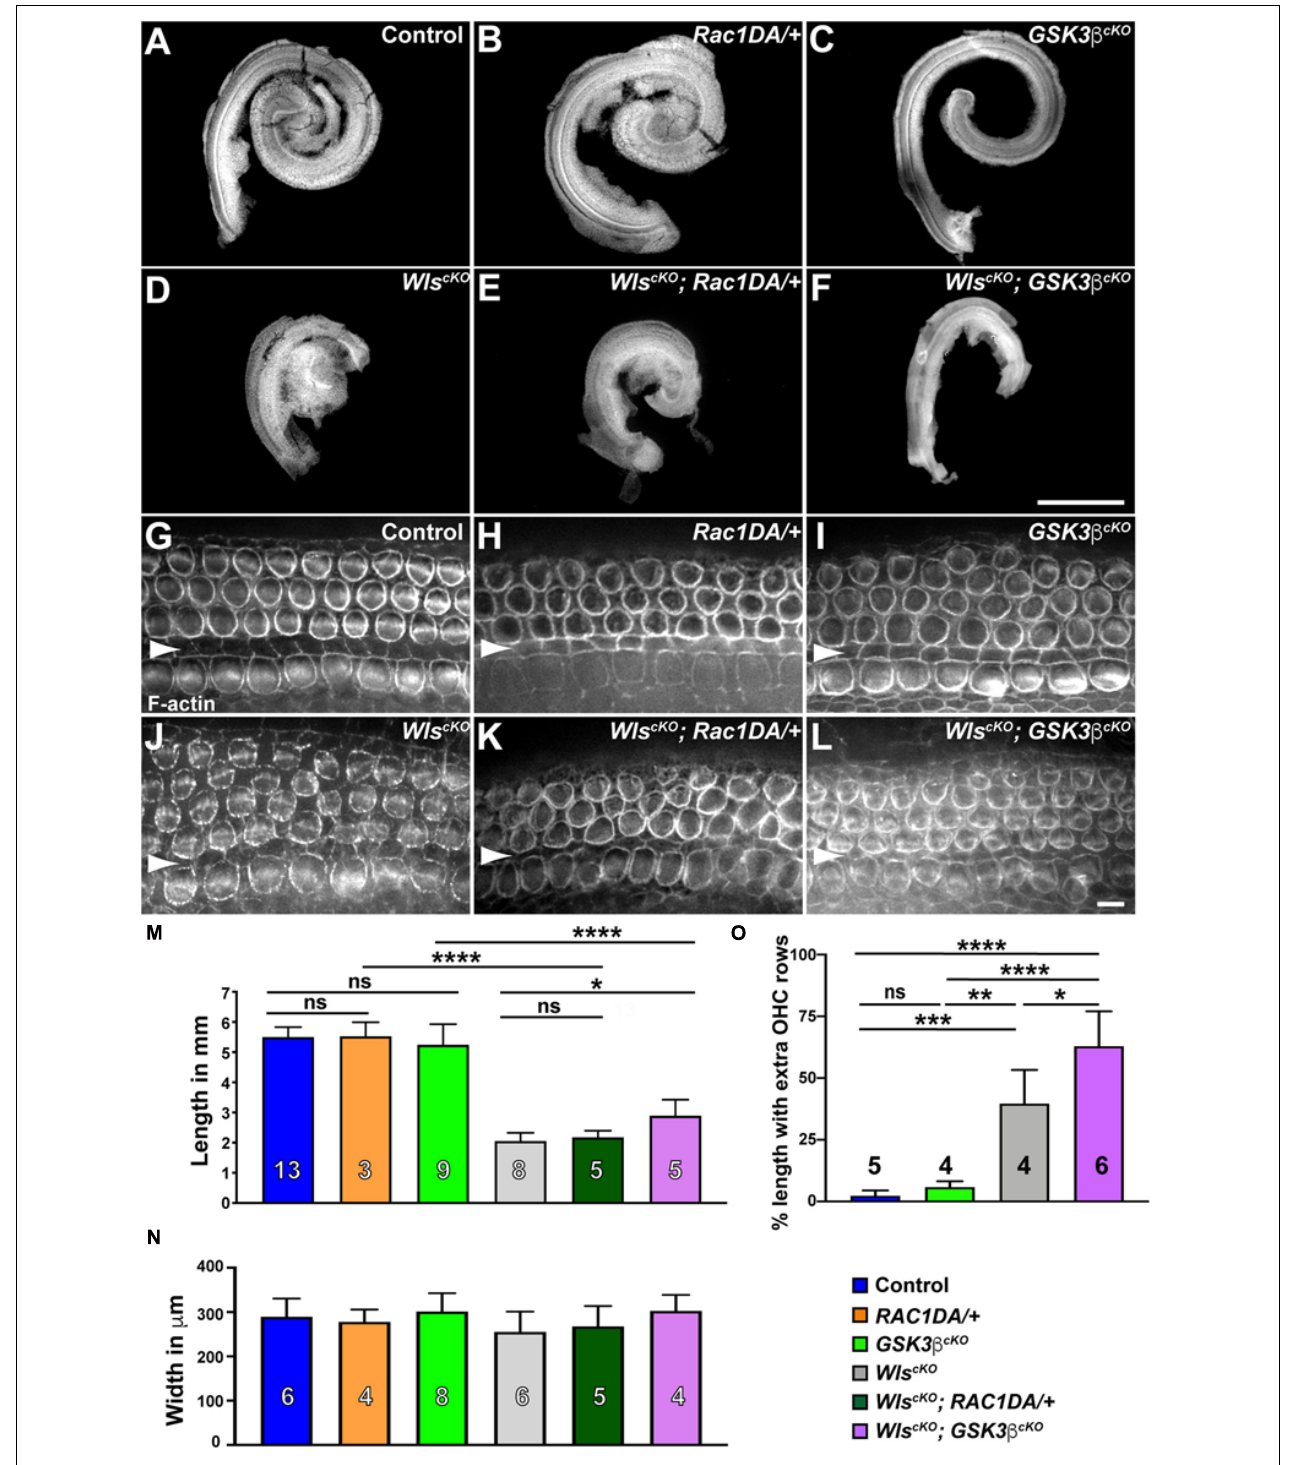
FIGURE 3 | Gsk3 β inactivation but not Rac1 activation partially rescued cochlear outgrowth of Wls cKO mutant. (A–F) Dissected cochlear ducts from E18.5 wild-type control ( A ), Rac1DA/ + (B) , Gsk3 β cKO (C) , Wls cKO (D) , Wls cKO ; Rac1DA/ + (E) , and Wls cKO ; Gsk3 β cKO (F) mutants. (G–L) Flat-mounted OC from the middle region (40–60% cochlear length) of wild-type control (G) , Rac1DA/ + (H) , Gsk3 β cKO (I) , Wls cKO (J) , Wls cKO ; Rac1DA/ + (K) , and Wls cKO ; Gsk3 β cKO (L) cochleae stained by phalloidin. Arrowheads indicate the inner pillar cell row. Lateral is up. Scale bars: (A–F) , 1 mm; (G–L) , 6 µ m. (M–O) Quantifications of cochlear length (M) , cochlear duct width (N) , and presence of extra OHC rows (O) in genotypes indicated by the color keys. Cochlear duct width (N) was not significantly different in all pair-wise comparisons. The number of cochleae analyzed is indicated. Ns, not significant.